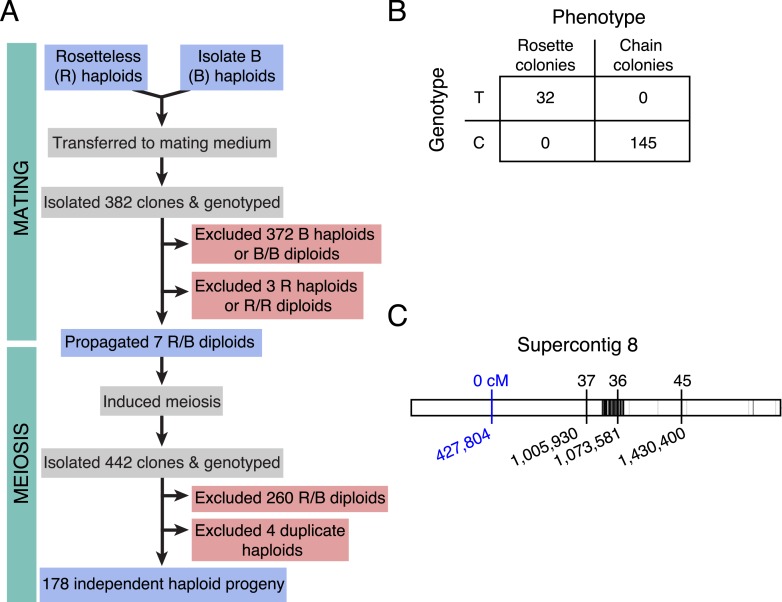
Rosetteless maps to EGD82922.(A) Design of the mapping cross. Rosetteless cells were mixed with Isolate B, an S. rosetta culture capable of forming rosettes. Mating was induced by starvation. To isolate the products of outcrossed mating, cells then underwent clonal isolation, and clonal populations were genotyped to identify outcrossed, diploid heterozygotes. These heterozygotes were expanded and induced to undergo meiosis, after which clonal isolation and genotyping were repeated. Haploid progeny of the cross were homozygous at all three markers. (B) 2 × 2 contingency table shows that the Rosetteless phenotype was tightly linked to the genotype of the supercontig 8: 427,804 candidate splice donor mutation. (C) Map of the supercontig 8 markers. Top numbers show the genetic distance between the markers and the Rosetteless phenotype in centimorgans (cM). Bottom numbers show marker genomic positions on supercontig 8. Black lines within the central bar show all sites of predicted polymorphism (i.e., possible marker positions) between Rosetteless and Isolate B. The blue marker is the EGD82922 splice donor mutation.DOI:
http://dx.doi.org/10.7554/eLife.04070.00910.7554/eLife.04070.010Figure 4—source data 1.Full genotyping data for all progeny of the Rosetteless x Isolate B cross.For each isolated progeny of the cross, we provide the phenotype when grown in HN media (chains or rosettes), the identity of the heterozygous flask from which the haploid isolate was derived (‘Flask isolated from’), and the genotypes at 60 SNV and microsatellite loci. For the microsatellite loci, numbers indicate the approximate size of the amplicon. Missing genotype data is indicated by ‘NA’. Color-coding shows genotypes and phenotypes that match Isolate B (white) or Rosetteless (yellow). Genotyping data was used to construct a linkage map for S. rosetta (Figure 4—figure supplement 3). For each marker, we list its linkage group and its inferred position within the linkage group. Four of the cross isolates were excluded from further analyses because their genotypes were identical to other cross isolates.